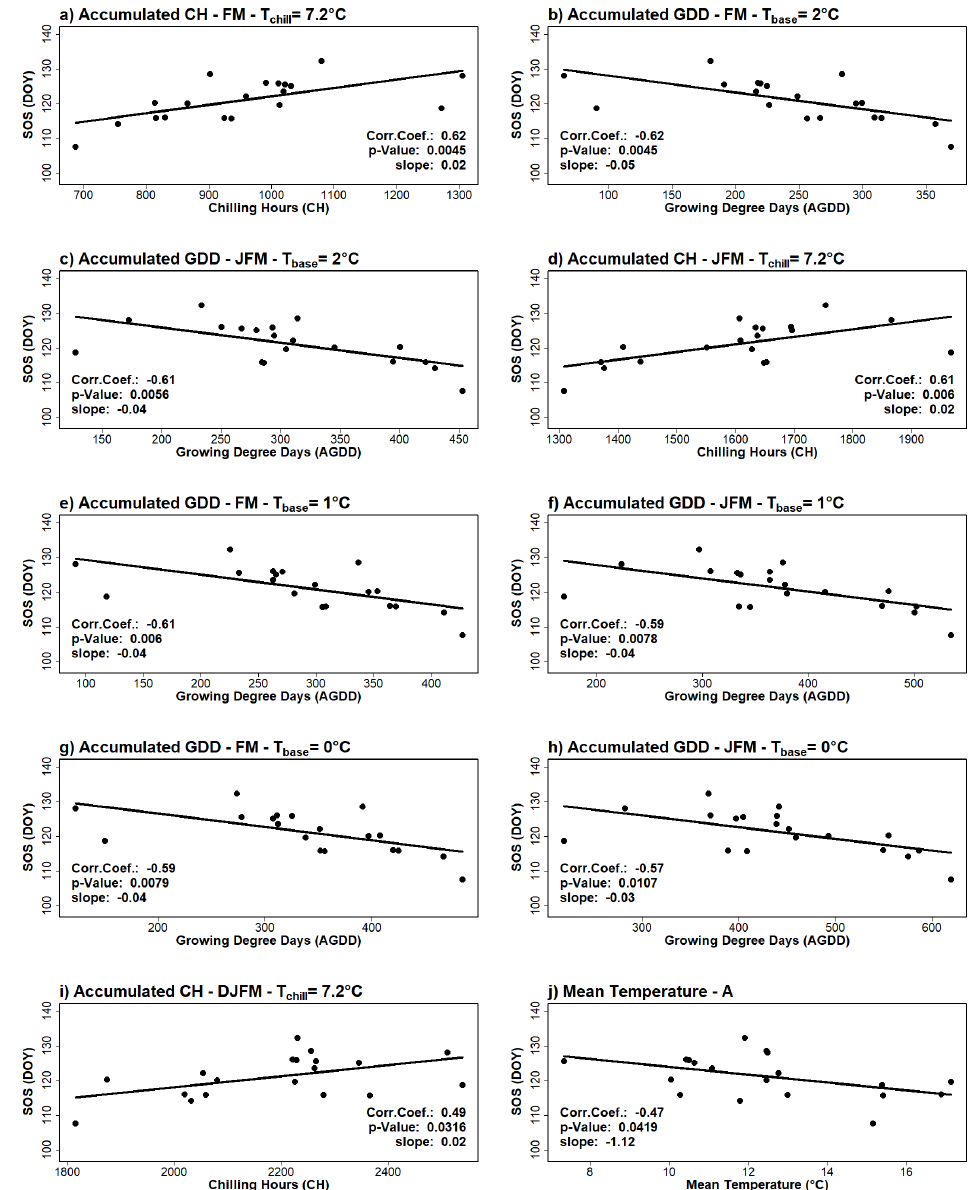
Figure 11. Plots of significant correlations between the mean SOS trend and temperature-derived variable/intervals ( a – j ). CH = chill hours; GDD = growing degree days; D, J, F, M, and A stand for